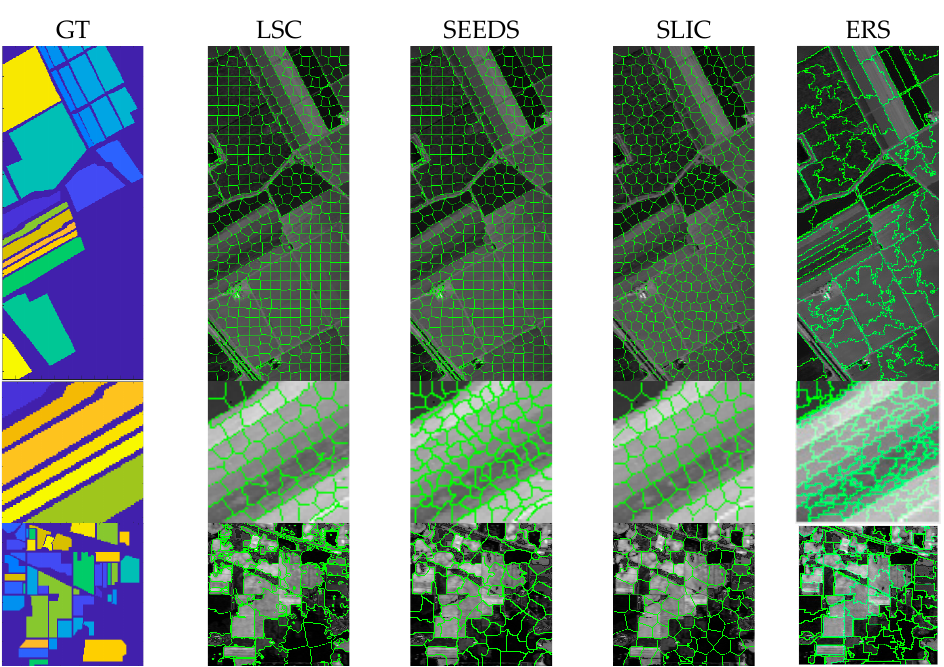
Figure 6. Segmentation results of different superpixel methods for SalinasA, Salinas and Indian Pines datasets (from top to bottom). Table 2. Results from various superpixel methods, results in bold highlight the best in the group. Indian Pines